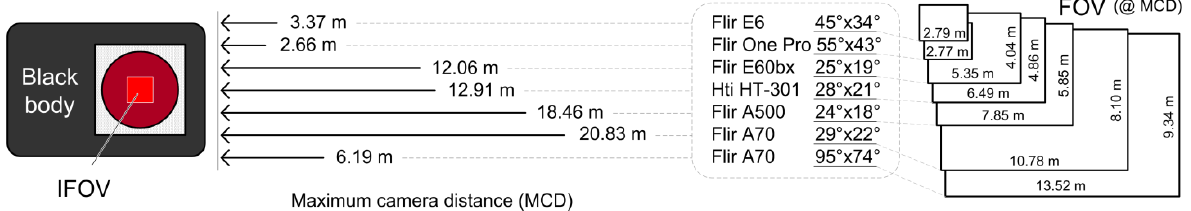
Figure 23. The maximum camera distance up to which accurate measurement is possible.